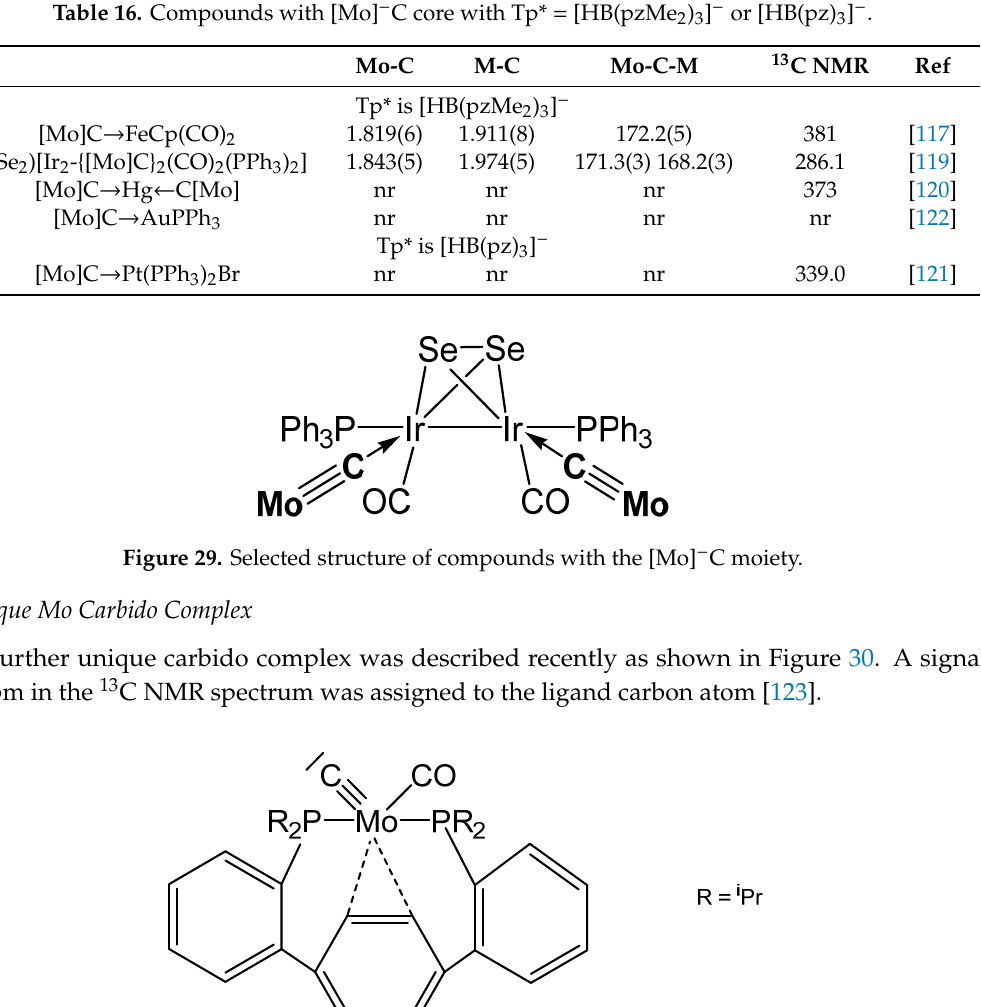
Figure 30. The carbido complex with the P 2 (CO)Mo ≡ C core.